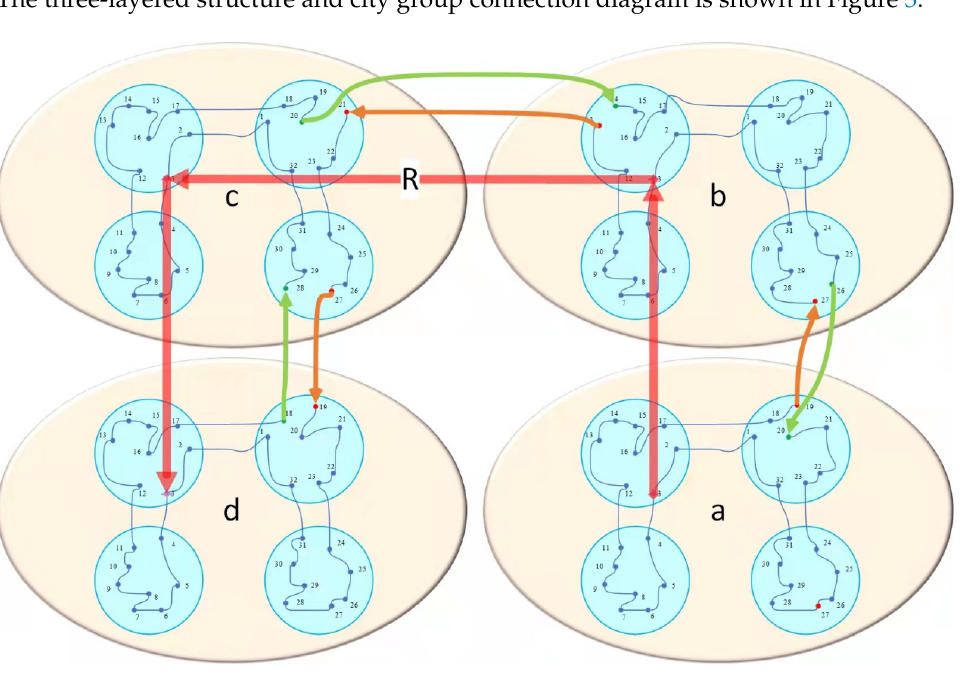
Figure 3. Three-layered structure and city group connection